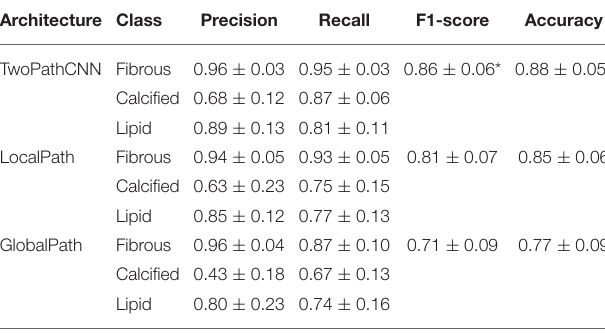
TABLE 1 | The confidence interval of performance on different CNN architectures, including precision, recall, F1-score, and